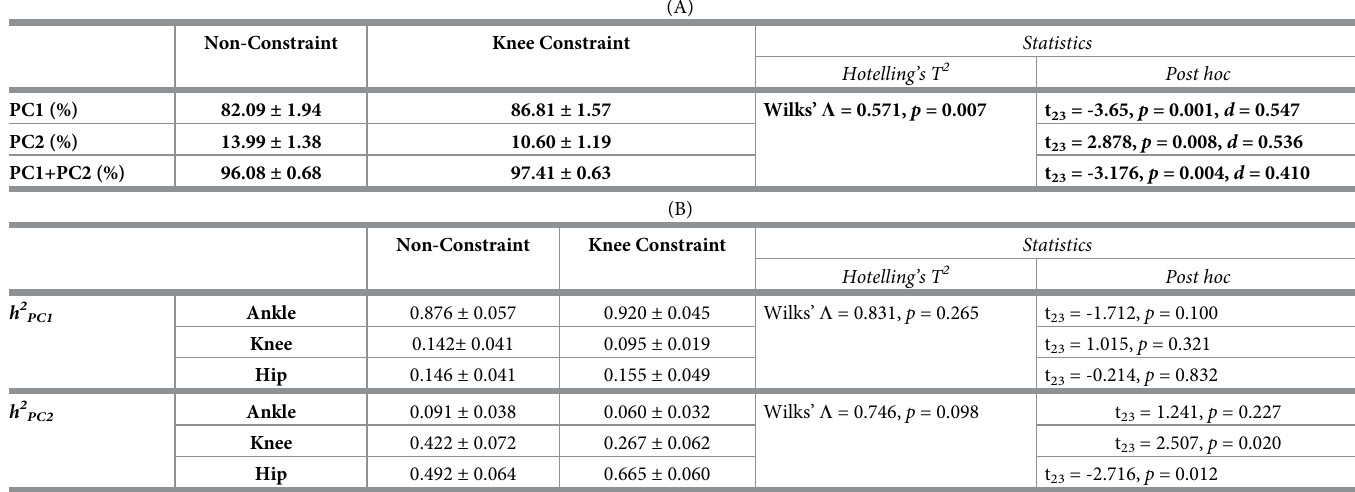
Table 2. (A) The amounts of variance that the first two principal components (PC1 and PC2) explain. (B) Communality of PC1 ( h 2 PC1 ) and PC2 ( h 2 PC2 ) in the two stance